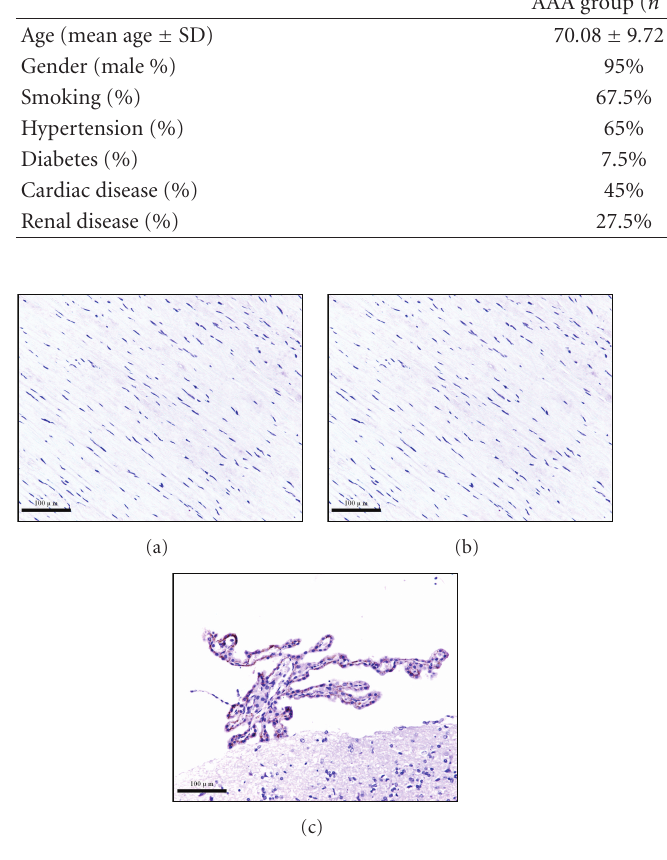
Figure 3: Representative staining pictures of S1P1 protein in AAA (a), control aortic (b) sections, and healthy adult rat brain para ffi n sections (c) ( × 200). S1P1 protein was undetectable in both types of tissues. Table 2: Staining scores of immunohistochemical analysis of S1P receptors in both types of tissues.